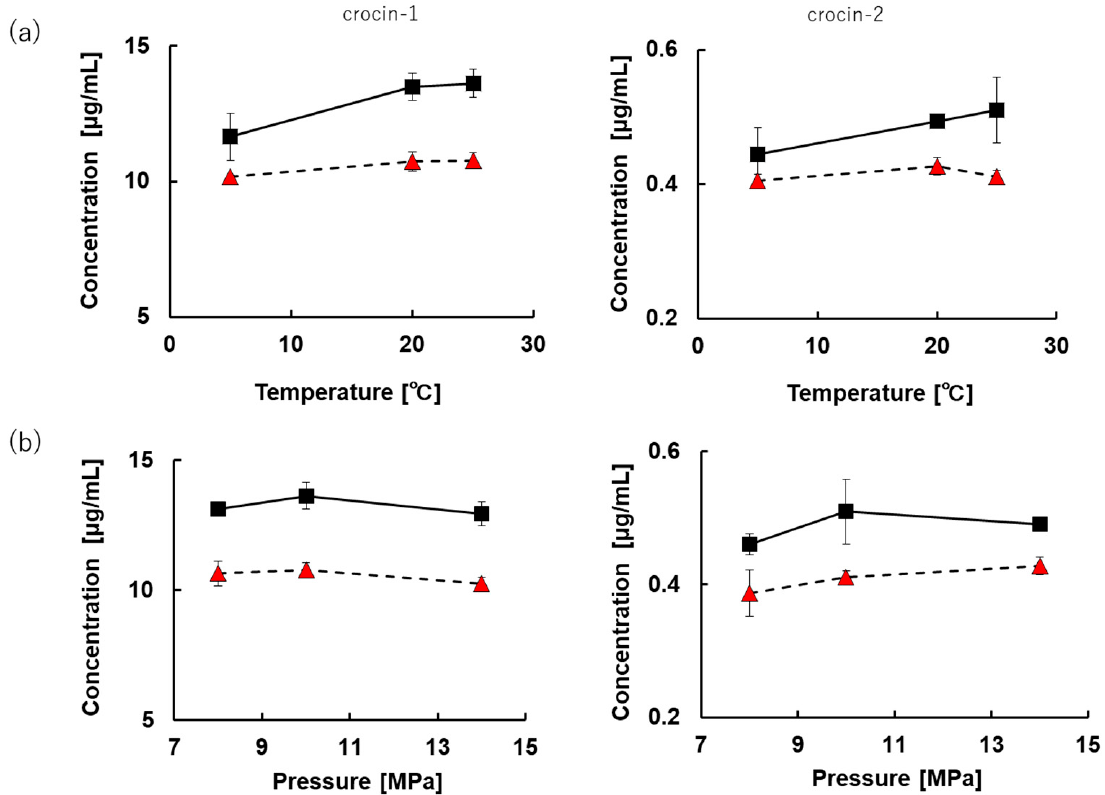
Figure 5. Effects of ( a ) temperature and ( b ) pressure on extraction concentration of crocin-1 and crocin-2 from gardenia fruit pulp in CXE80% extraction system at 25 °C and 10 MPa obtained with ( ■ ) and without ( ▲ ) ultrasound (amplitude 20%, 125 s). Error bars represent means ± SE (n = 3).